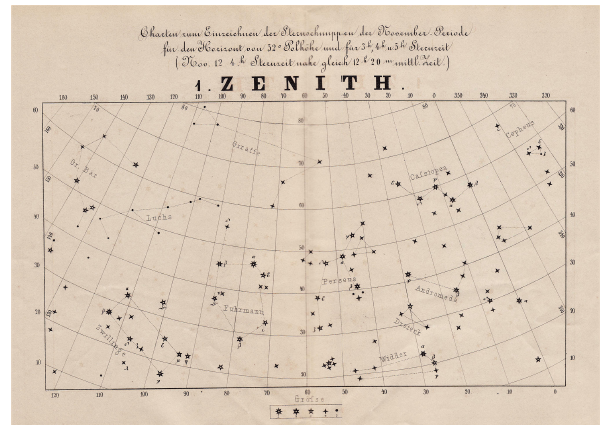
Figure 8. Chart 1 of the collection of Charts for the November Pe- riod (Heis,